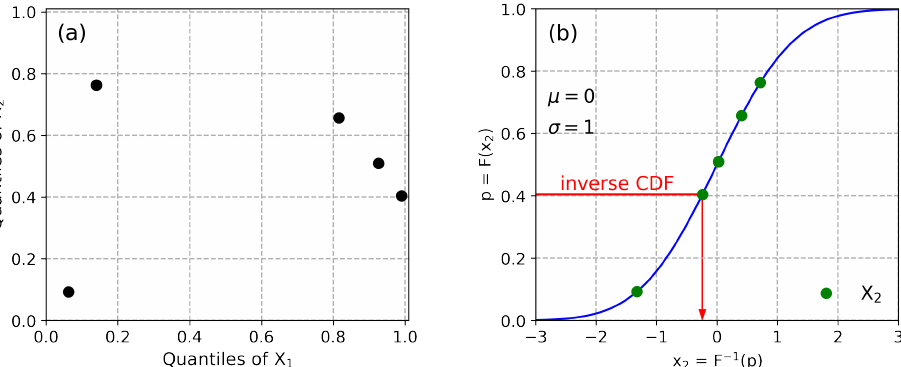
Figure 1. ( a ) A sampling design with n = 5 realizations generated by MCS in a two-dimensional sampling space where the random variables are independent, ( b ) Mapping the quantiles according to the standard Gaussian distribution using the inverse transform